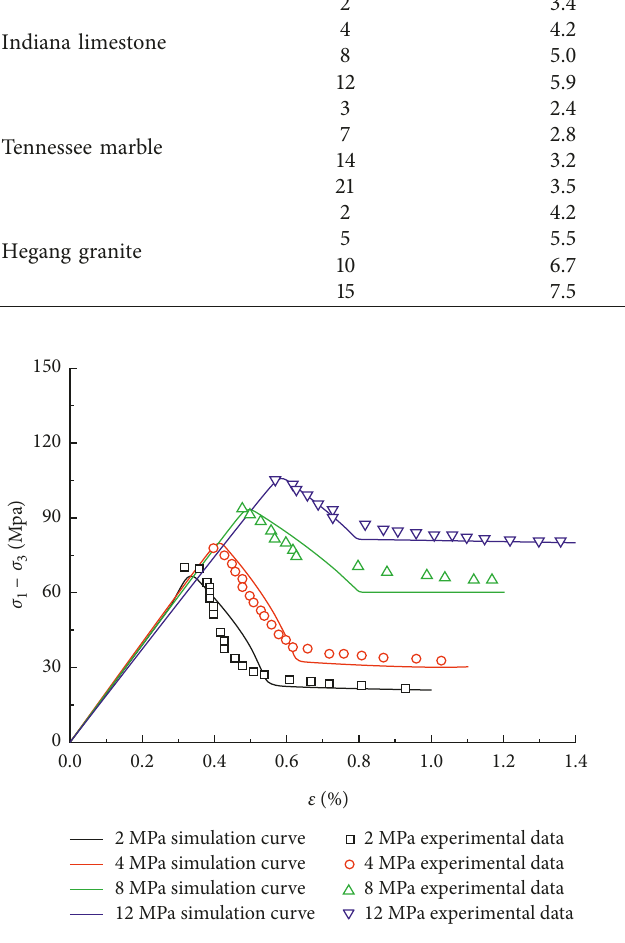
Figure 10: Comparison between Indiana limestone triaxial com- pression test data and numerical simulation curves.